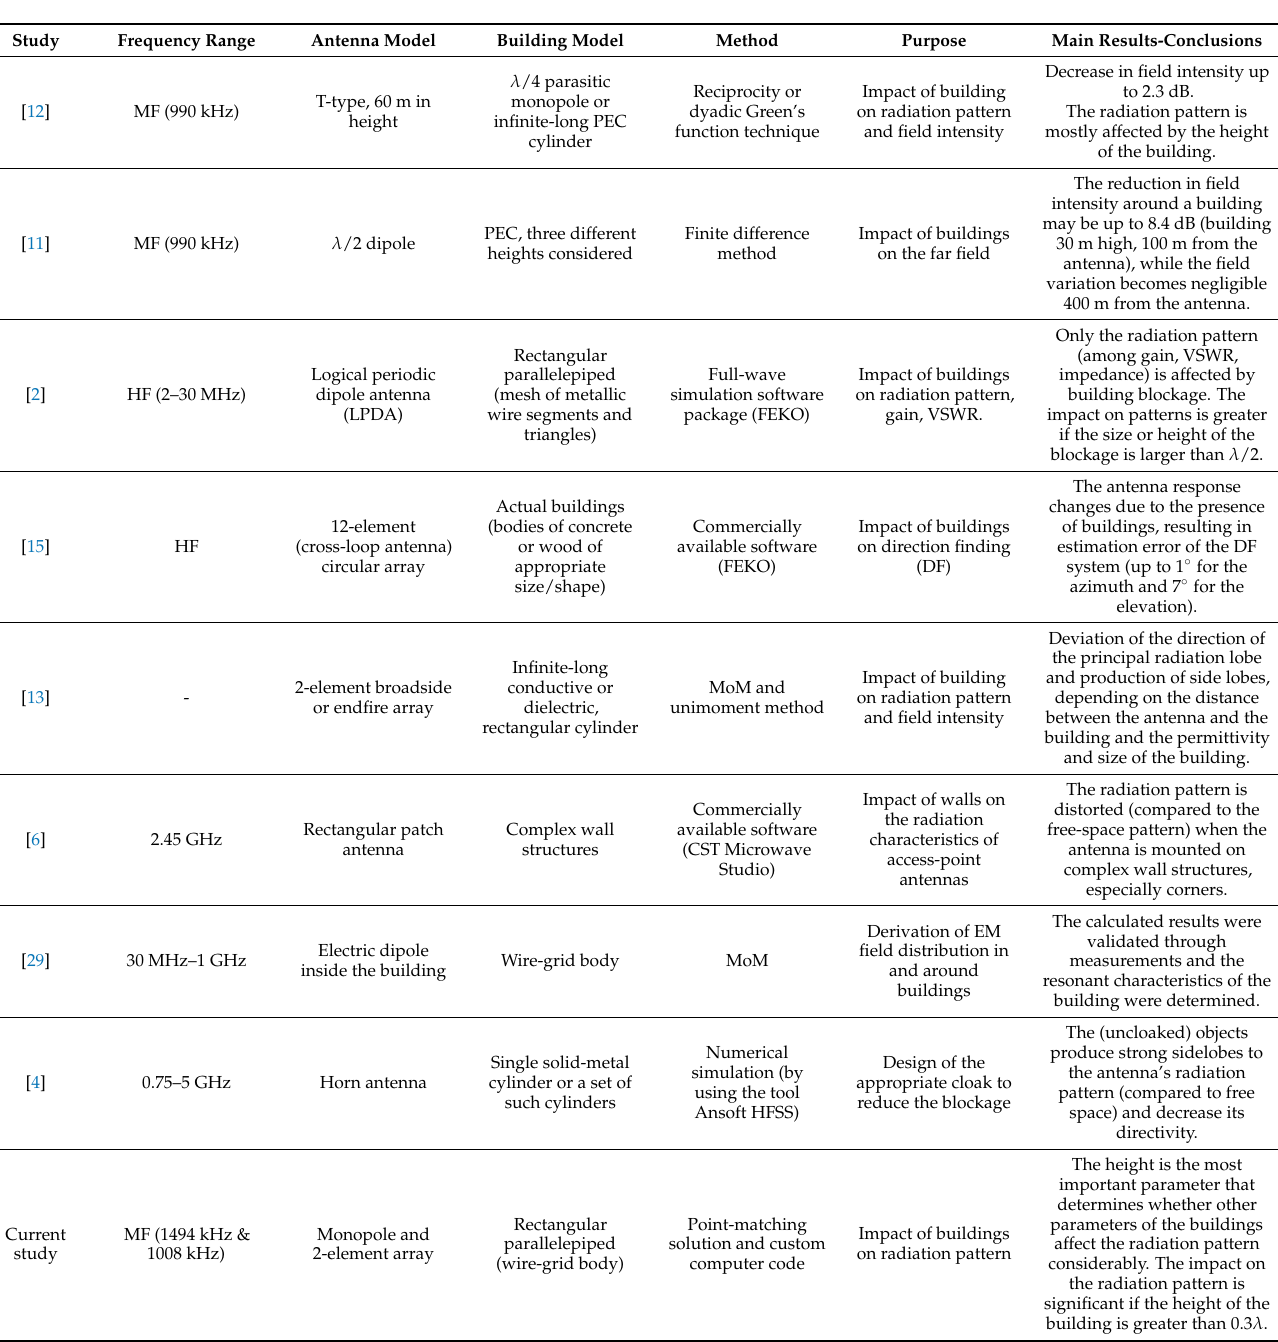
Table 1. Comparative synopsis of studies dealing with the effect of buildings on antenna